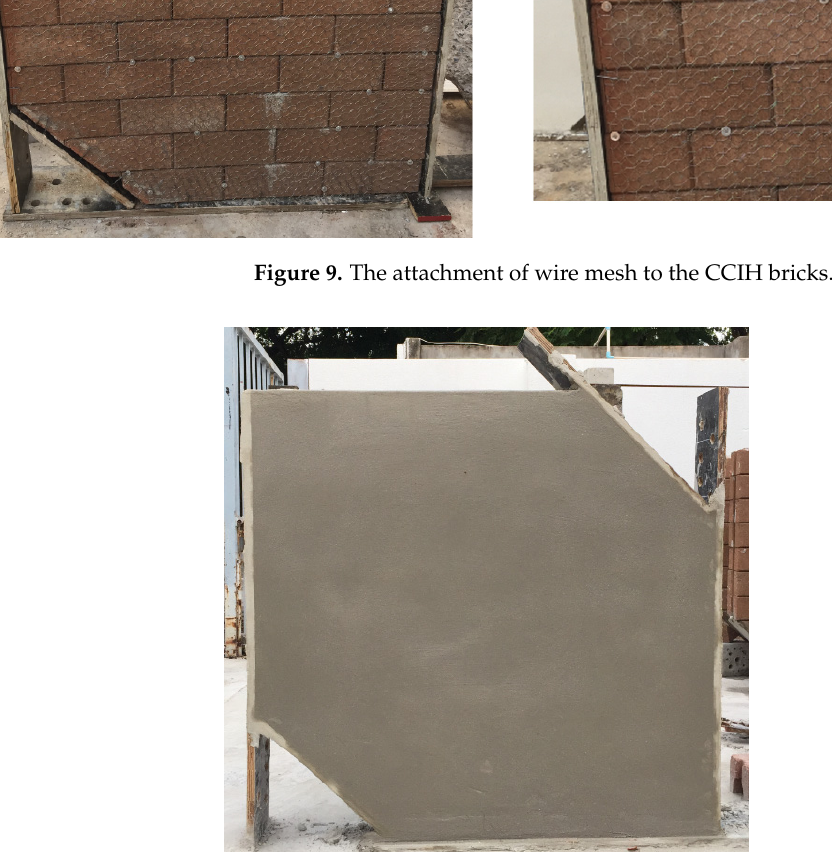
Figure 10. CCIH brick masonry wall with CEMENT mortar.